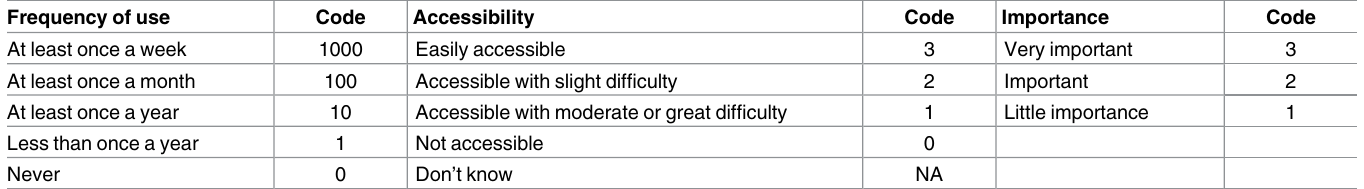
Table 2. The coding systemused to score managers’ responses to questions about the frequency of use, accessibility and importance of each source of evidence. Frequency of use